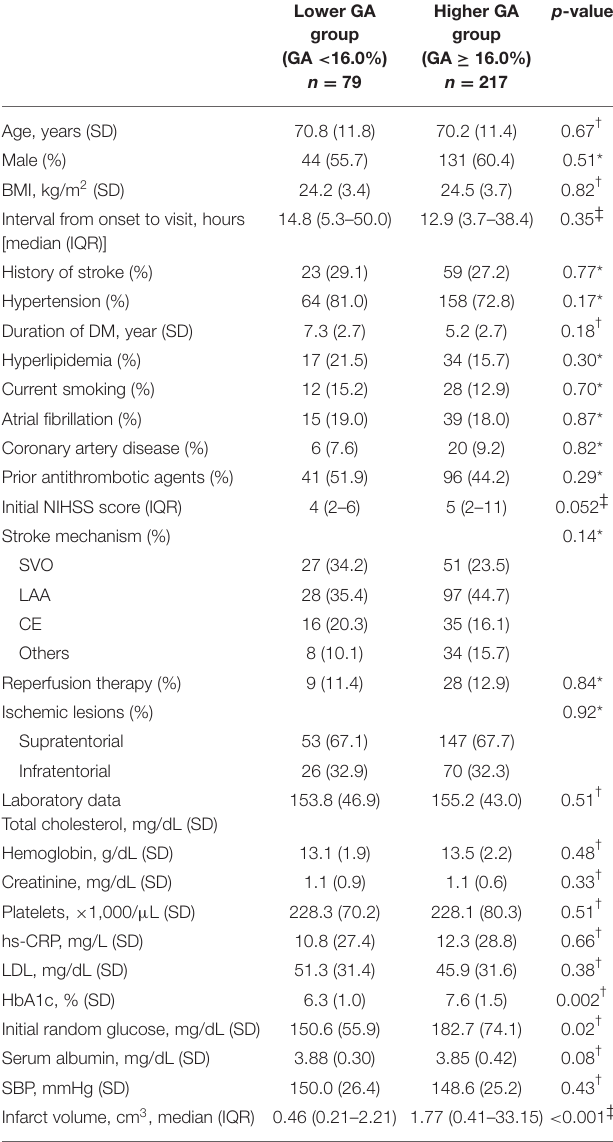
TABLE 1 | Baseline characteristics of the study population ( n = 296) according to GA